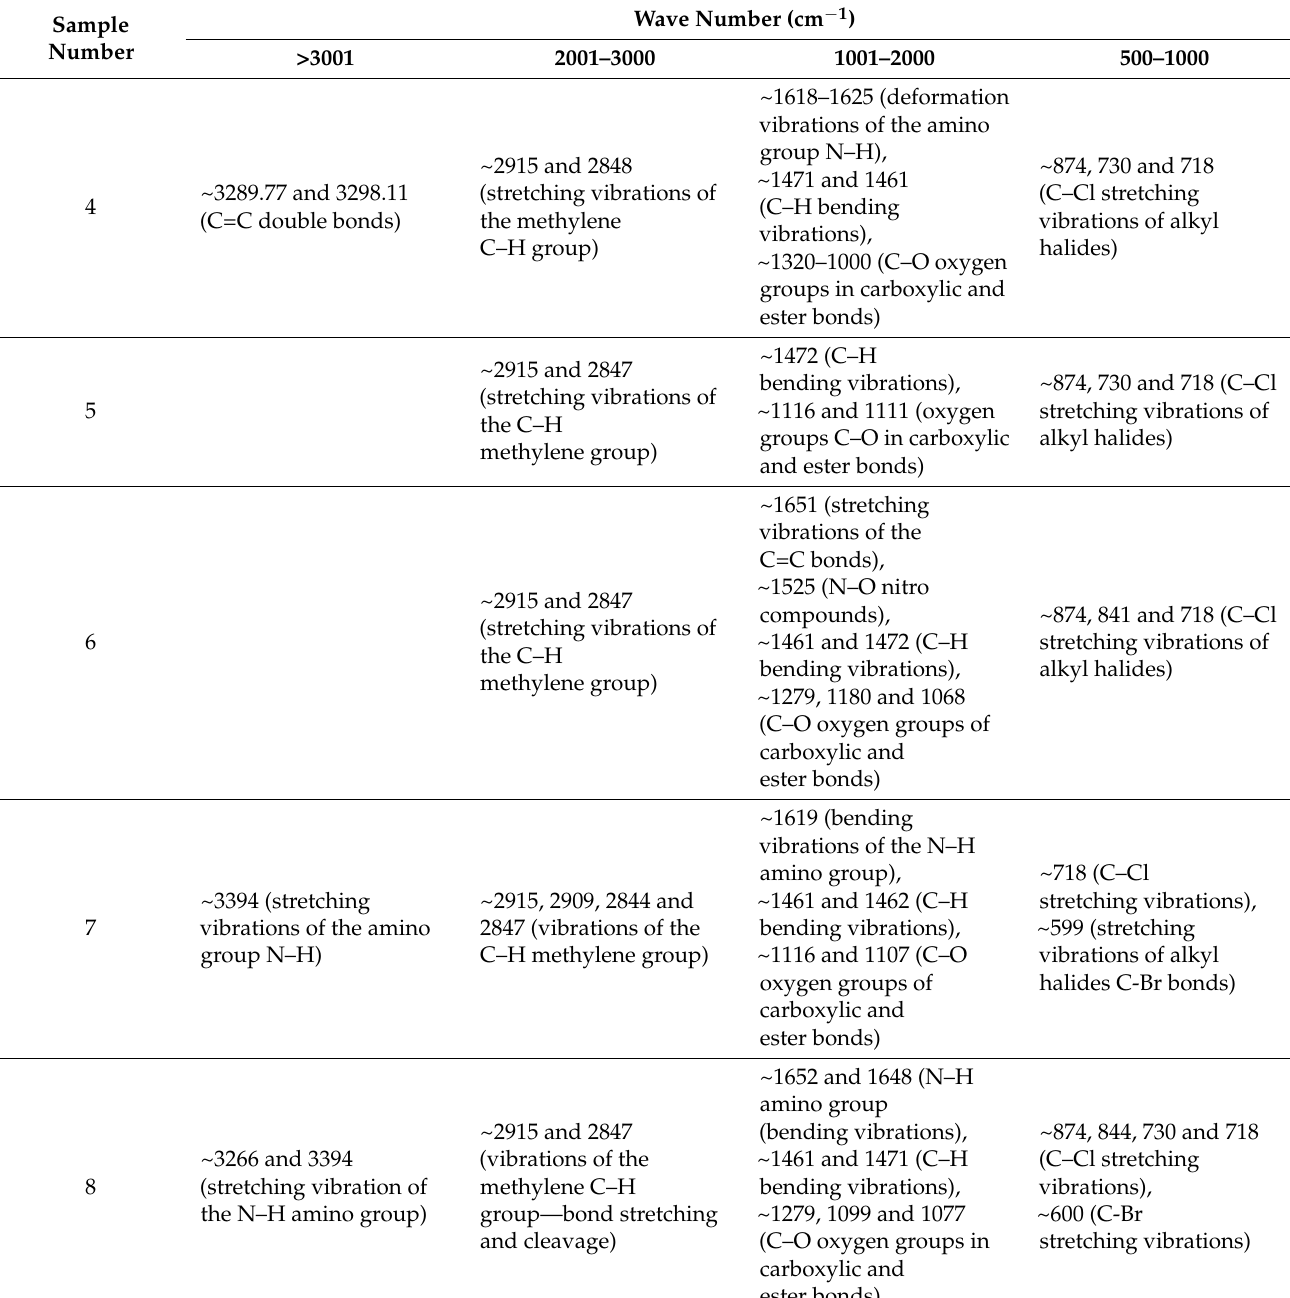
Table 2. List of changes noticed during the analysis of the Fourier transform infrared (FTIR) spectra of the tested packages (samples 4, 5, 6, 7, 8, 9, 10, and